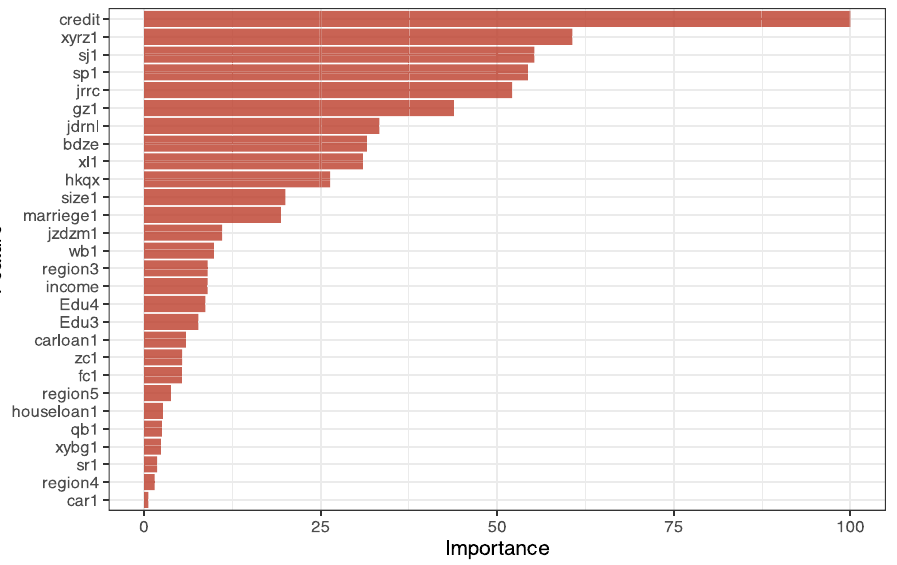
Figure 2. Importance ranking of the impact of variables on repayment failure